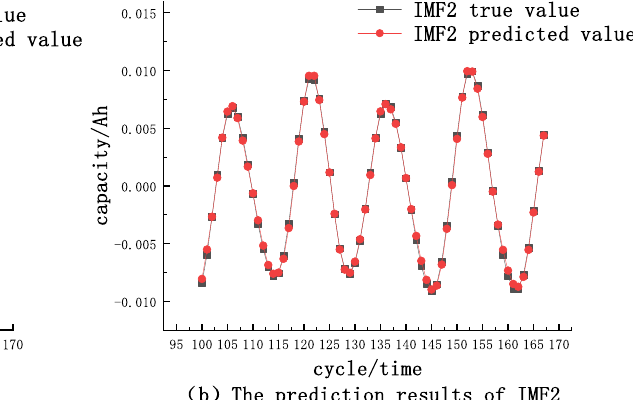
Figure 6. B0005 Decomposition Results.